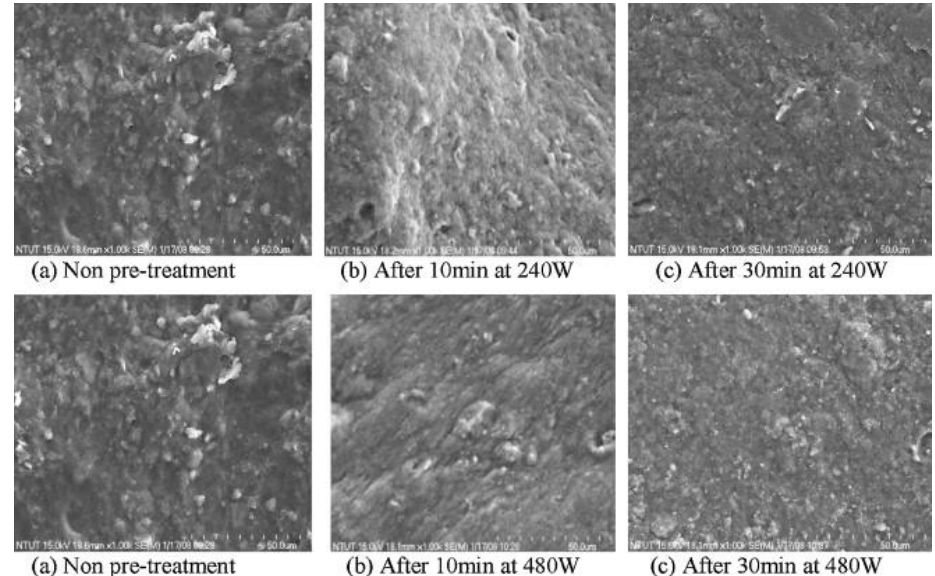
Figure 2. The morphology of the floc structure of sludge before and after ultrasonic pre-treatment under SEM [36]. Note: different lowercases represents food waste without ultrasound treatment (a), with sonication for 10 min (b) and with sonication for 30 min (c).